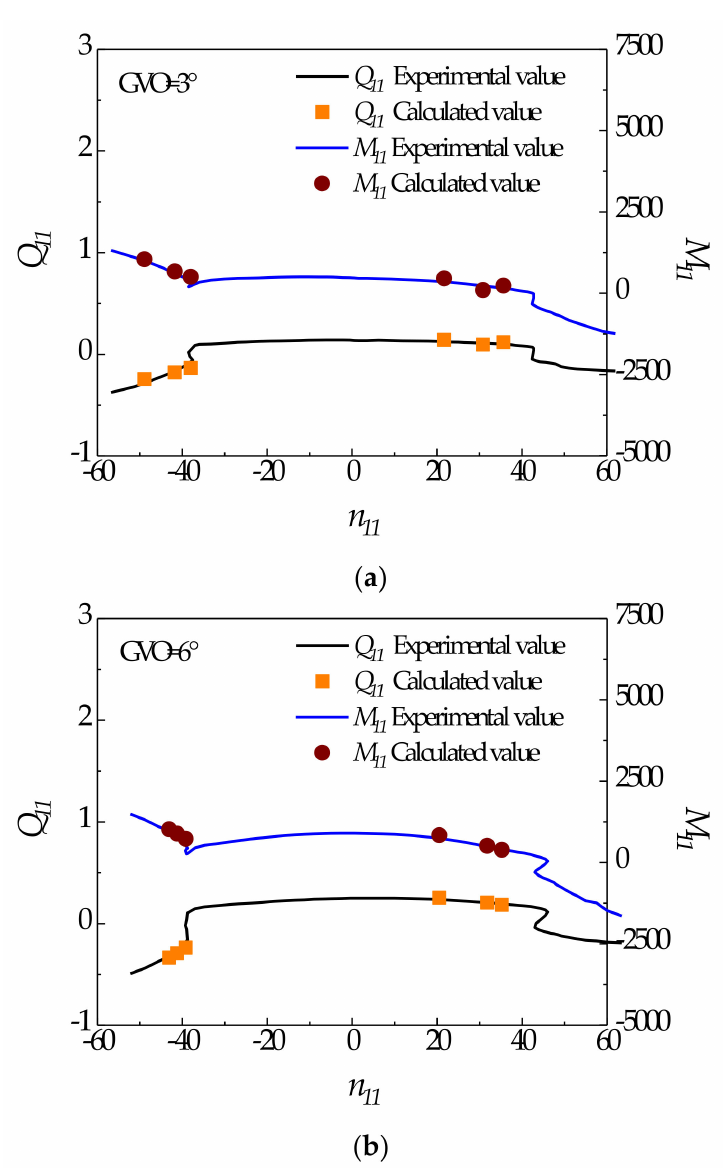
Figure 5. Numerical model validation results for different GVOs of ( a ) 3 ◦ and ( b ) 6 ◦